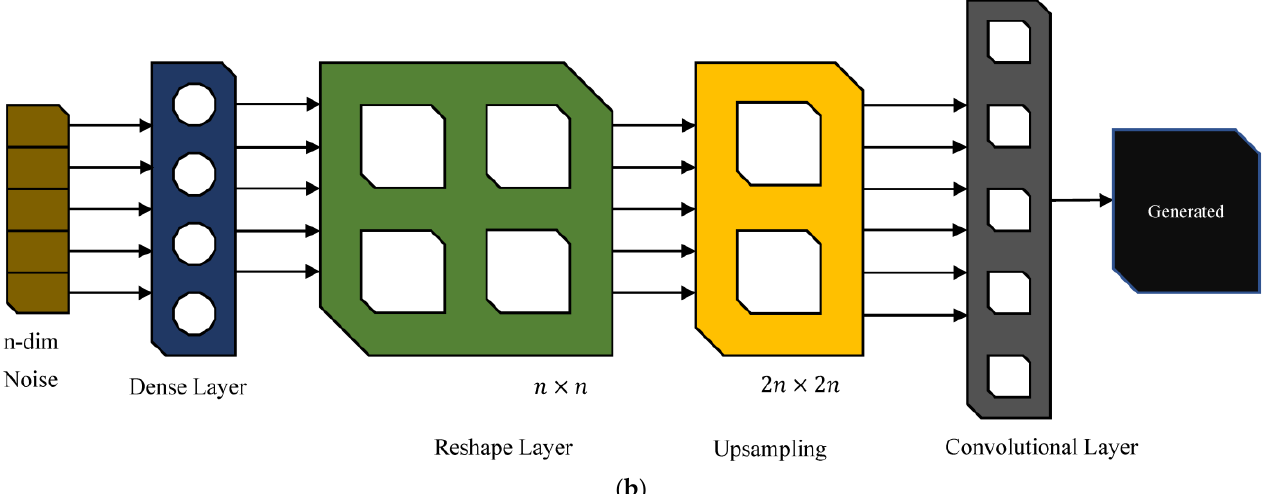
Figure 4. DCGAN Architecture [29]. ( a ) Discriminator, ( b ) Generator.